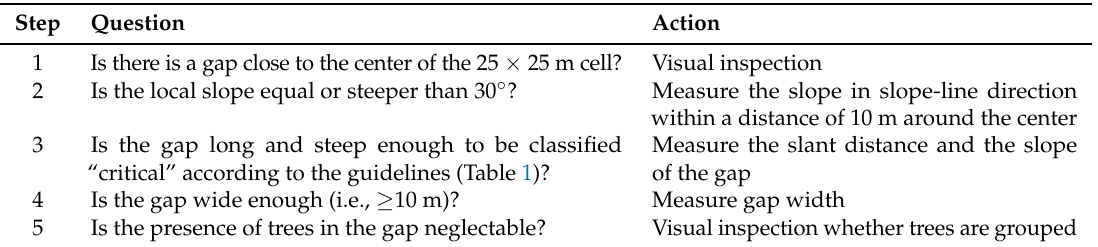
Table 2. Questionnaire used for the field